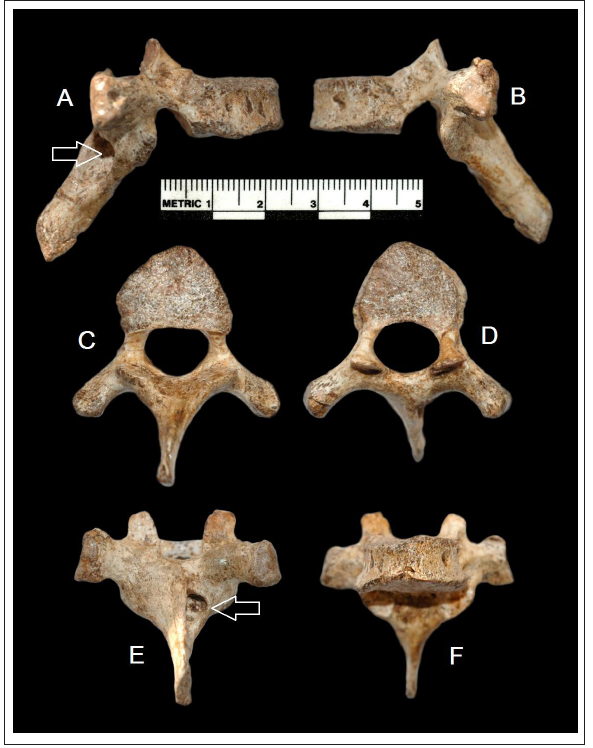
Figure 2: Vertebra U.W. 88-37. Photographs of surface morphology of U.W. 88-3 showing position of lesion on right side of vertebral lamina: (a) right lateral aspect, (b) left lateral aspect, (c) inferior aspect, (d) superior aspect, (e) posterior aspect, (f) anterior aspect. Note that apertures seen on lateral aspects of the vertebral body in images (a), (b) and (f) represent normal vascular foramina infilled with residual breccia matrix. Images produced by Peter Schmidt.